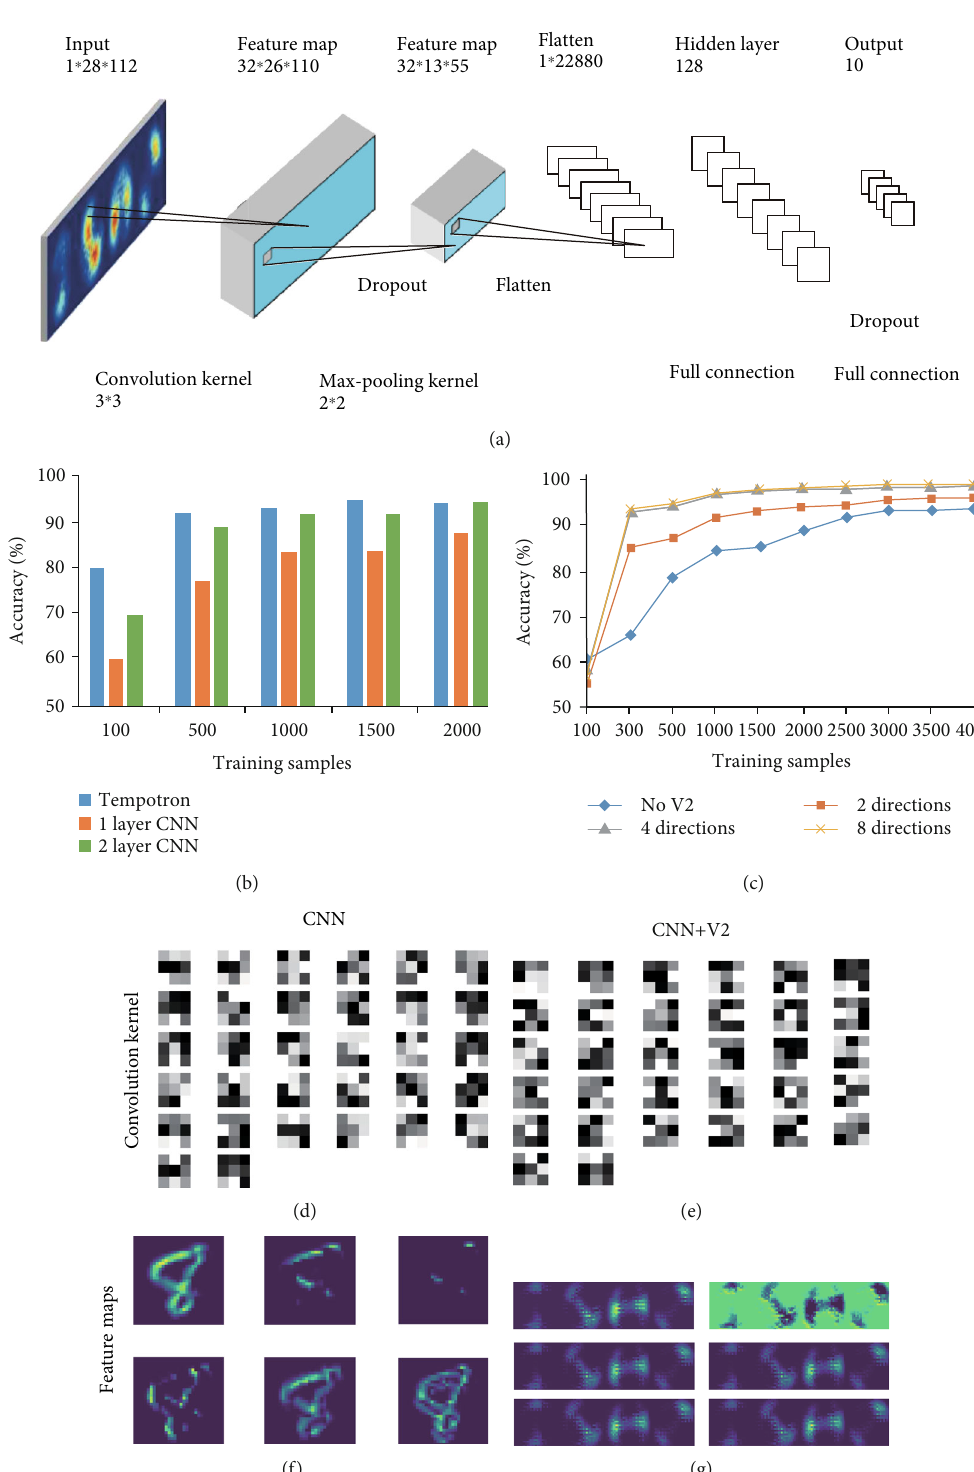
Figure 4: (a)The architecture of the convolutional neural network (CNN). The convolutional layer has 32 convolution kernels of size 3 × 3 . The pooling layer has kernels of size 2 × 2 . The output layer is a fully connected layer of 128 × 10 , which is mapping to 10 classes. (b) The comparison of classi fi cation accuracy between our model and CNN with one or two convolutional layers in the tasks for di ff erent number of training samples. The testing sample is 1000 . (c) The performance of 1 layer CNN by adding V2 layer with two, four, or eight directions before the convolutional layer. The two directions are horizontal and vertical while the four and eight directions are in 45 ° or 22 : 5 ° increments, respectively. The convolutional kernels (d, e) and feature maps (f, g) for CNN ( 1 convolutional layer) with or without the V2 layer are